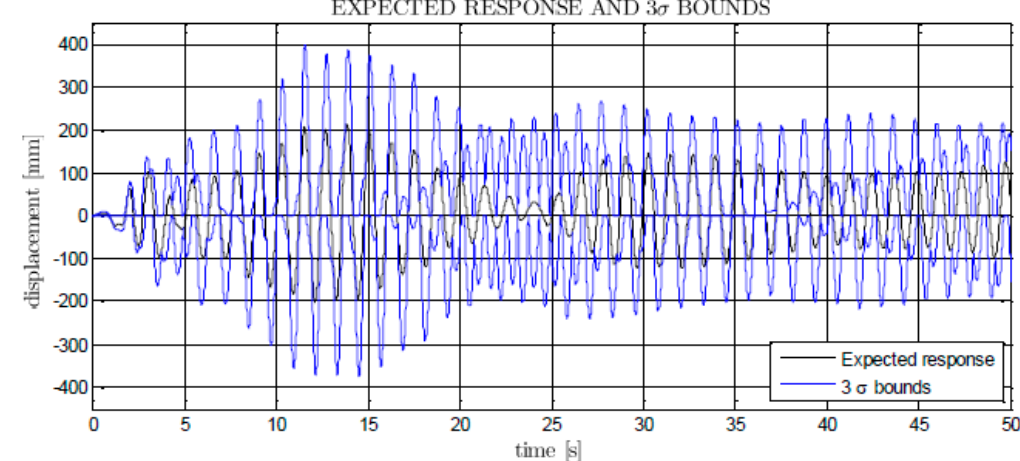
Figure 12: Expected response and bounds of the disordered BW